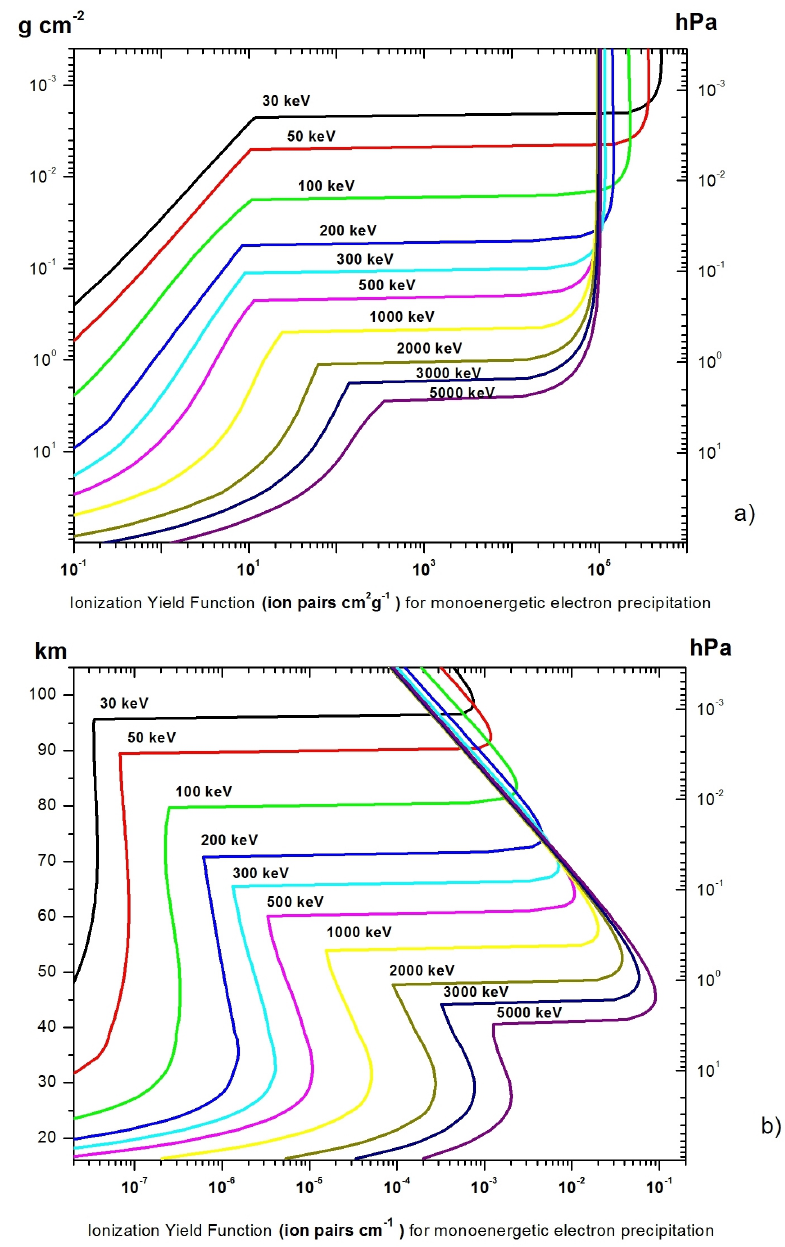
Figure 2. Ion production or yield function induced by the isotropic monoenergetic electron precipita- tion with an electron energy range of 30 keV–5000 keV. Top panel, ( a ): yield function Y ( x , E ) (ion pairs cm 2 g − 1 ) vs. atmospheric depth x (g cm − 2 ); see also the Supplementary Materials of this paper. Bottom panel, ( b ): product Y ( x , E ) · ρ (ion pairs cm − 1 ) vs. atmospheric altitude h